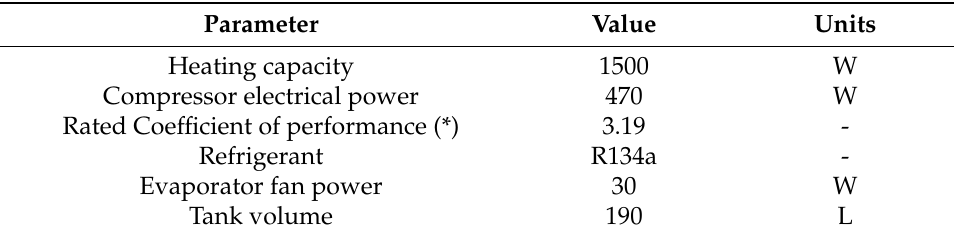
Table 1. Technical data of the heat pump water heater. Model MIDEA Compak KHP 15 190 (Kaysun Corporation, Manitowoc, WI, USA).